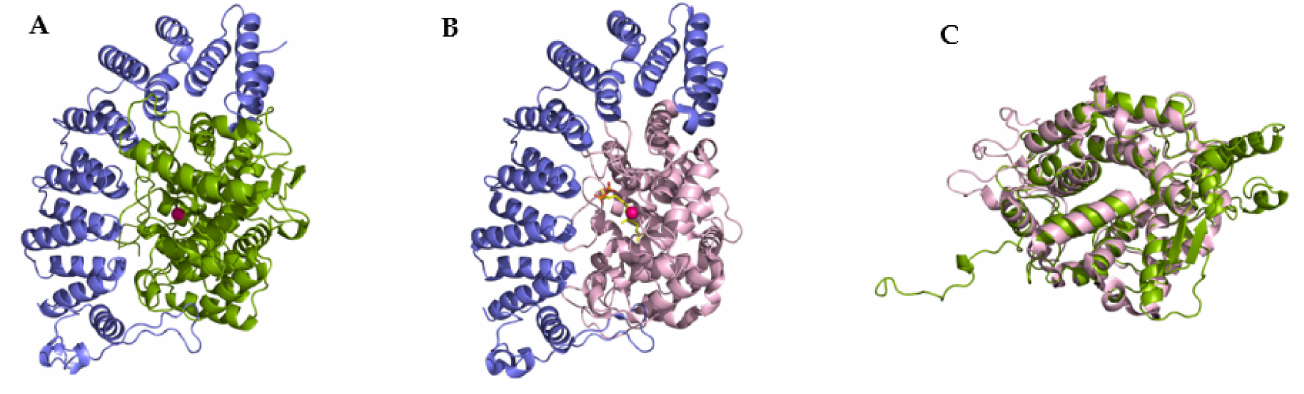
Figure 2. Overall structures of FTase ( A ) (PDB: 1FT1) and GGTase-I ( B ) (PBD: 1N4P), with the α subunit shown in blue, the FTase β subunit in green, and the GGTase-I β subunit in pink. The catalytic zinc ion is shown in red. Superposition of β subunit of FTase and GGTase-I ( C ). (Created in the PyMOL Molecular Graphics System, Version 2.5.2 Schrödinger,